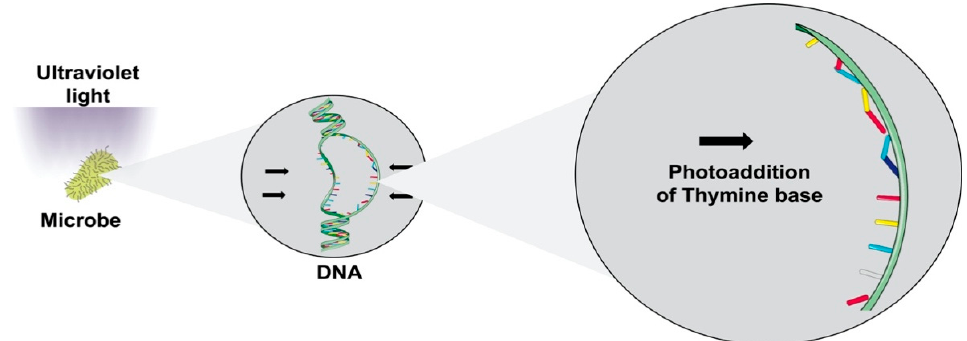
Figure 2. Photodimerization process. Source: Smart Service Medical Art.